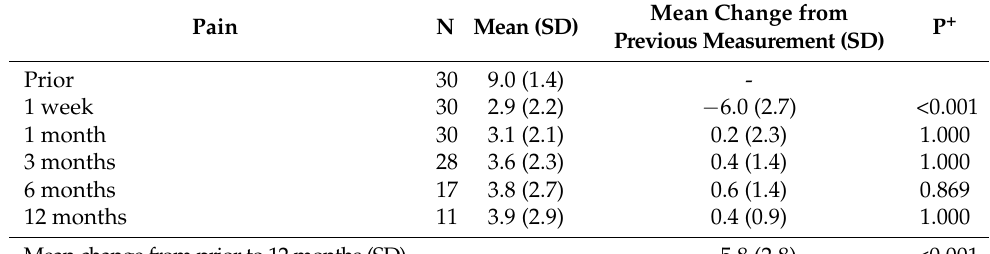
The pain measurements are presented in Table 2. Mean change from prior measure- ment to 1 week after was significant and equal to − 6.0 (SD = 2.7) ( p < 0.001). The changes between the following consecutive measurements were not significant ( p > 0.05). Overall mean change from prior measurement to 12 months was significant and equal to − 5.8 (SD = 2.8) ( p < 0.001). Pain was significantly diminished throughout the follow-up period ( β = − 0.01; SE = 0.003; p = 0.043). Furthermore, it was found that pain decreased signifi- cantly from prior to the first week measurement ( β = − 0.85; SE = 0.06; p < 0.001) and then it remained at a similar level until 12 months after ( β = 0.005; SE = 0.003; p = 0.127) (Figure 2). Table 2. Participants’ pain levels throughout follow-up.